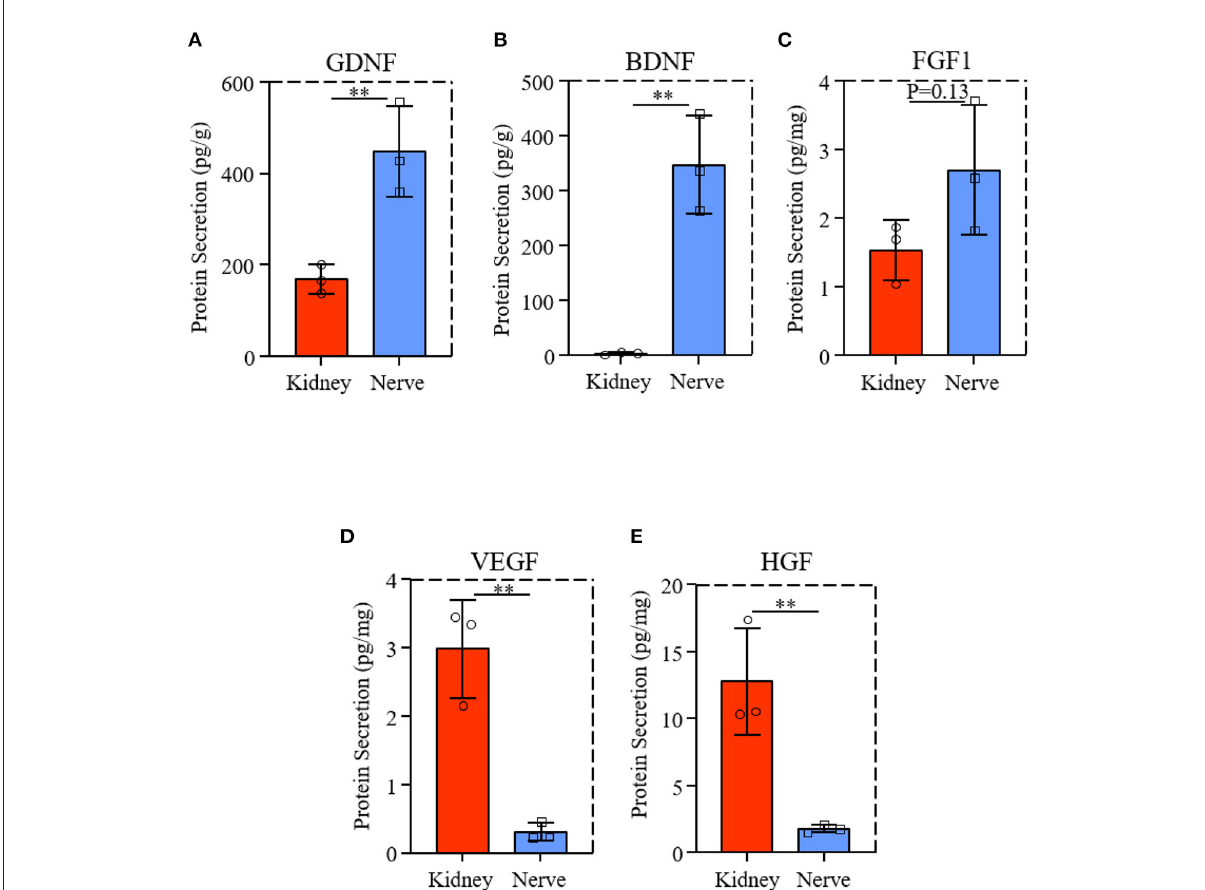
FIGURE7 Neurotrophic factors and growth factors expression from dK and dN; (A–C) ELISA result of GDNF, BDNF, FGF1; (D,E) VEGF and HGF content in decellularized tissues. ** P ≤